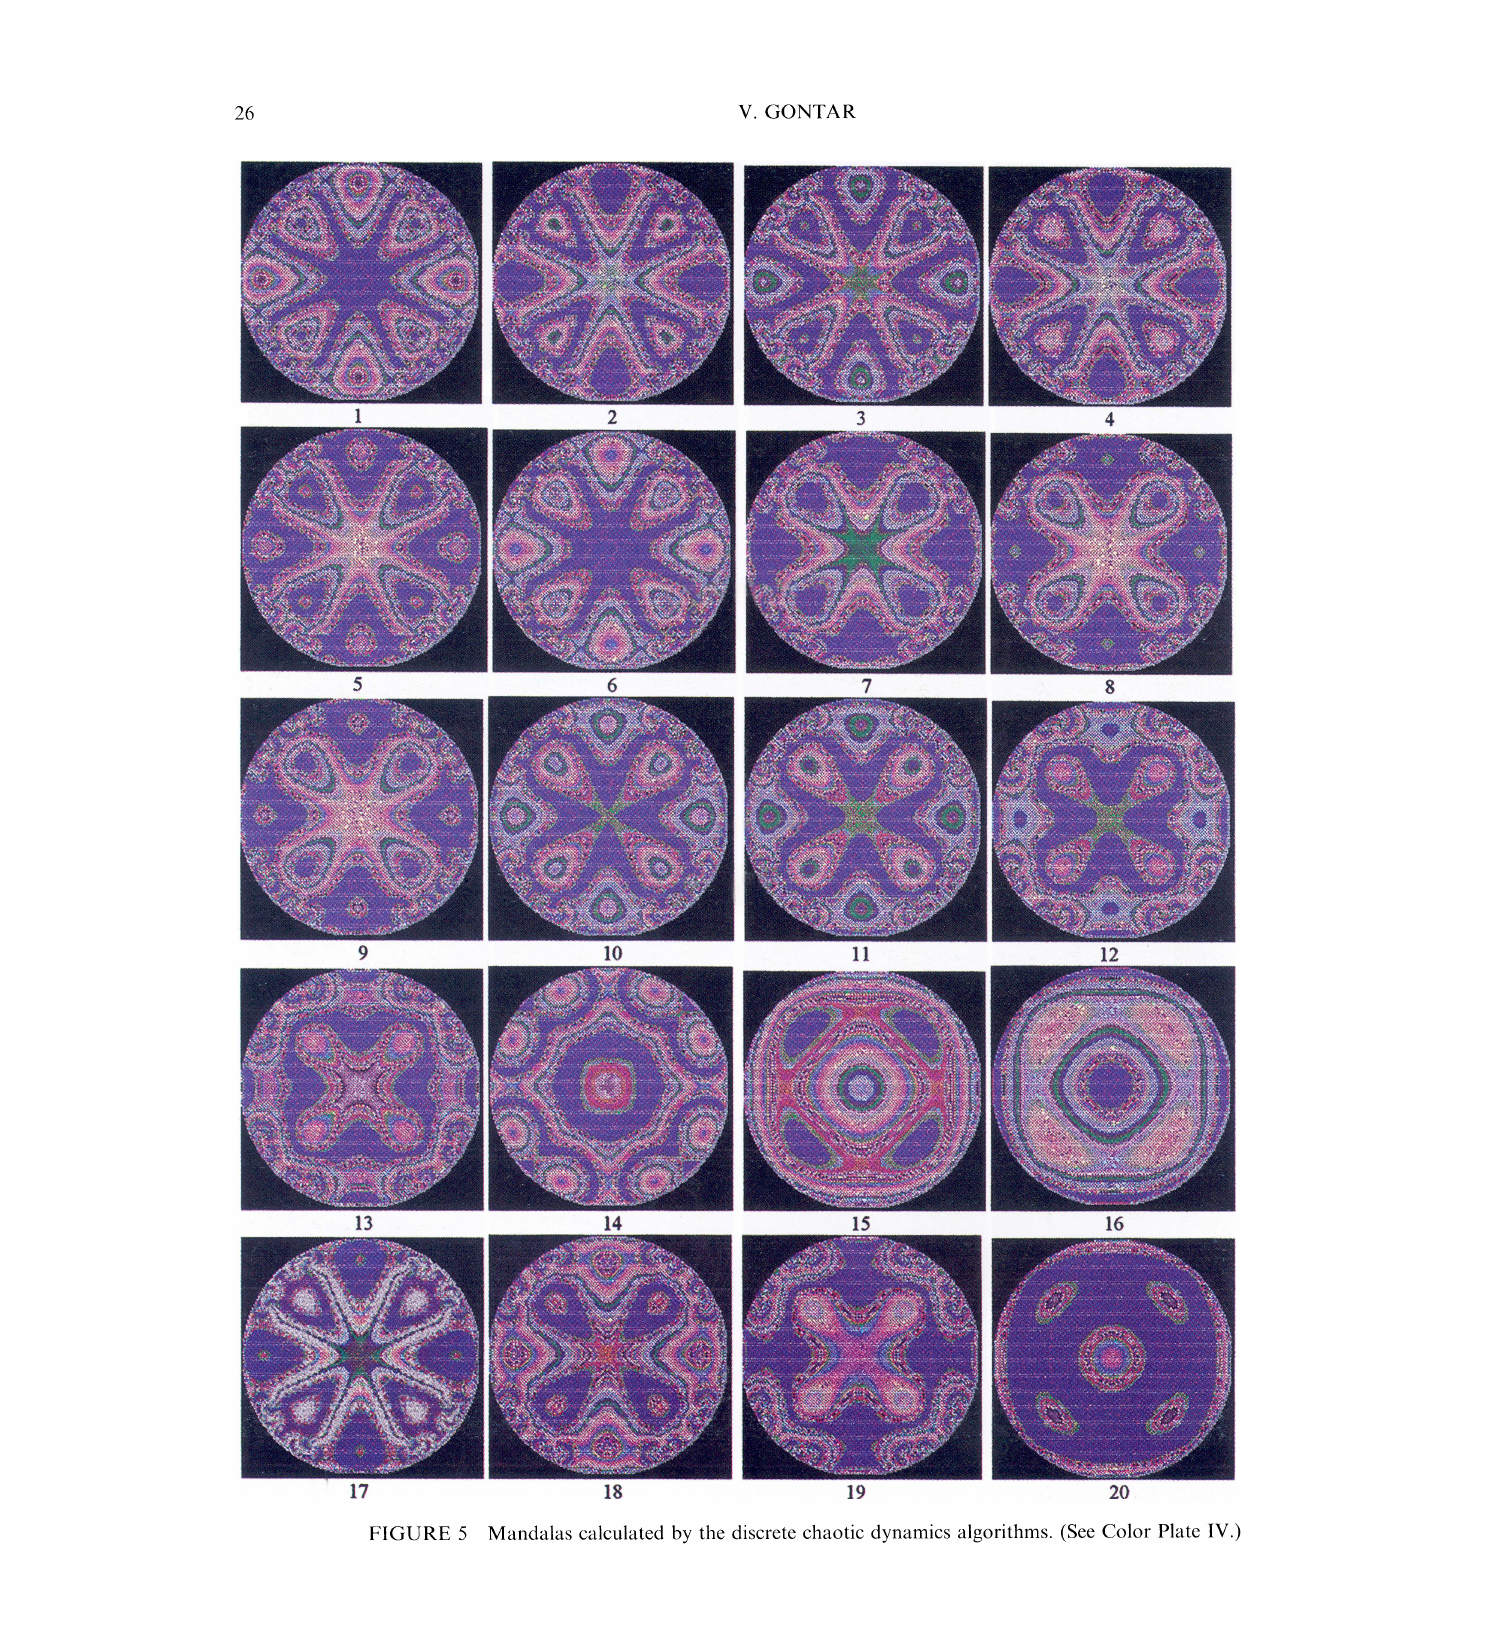
FIGURE 5 Mandalas calculated by the discrete chaotic dynamics algorithms. (See Color Plate